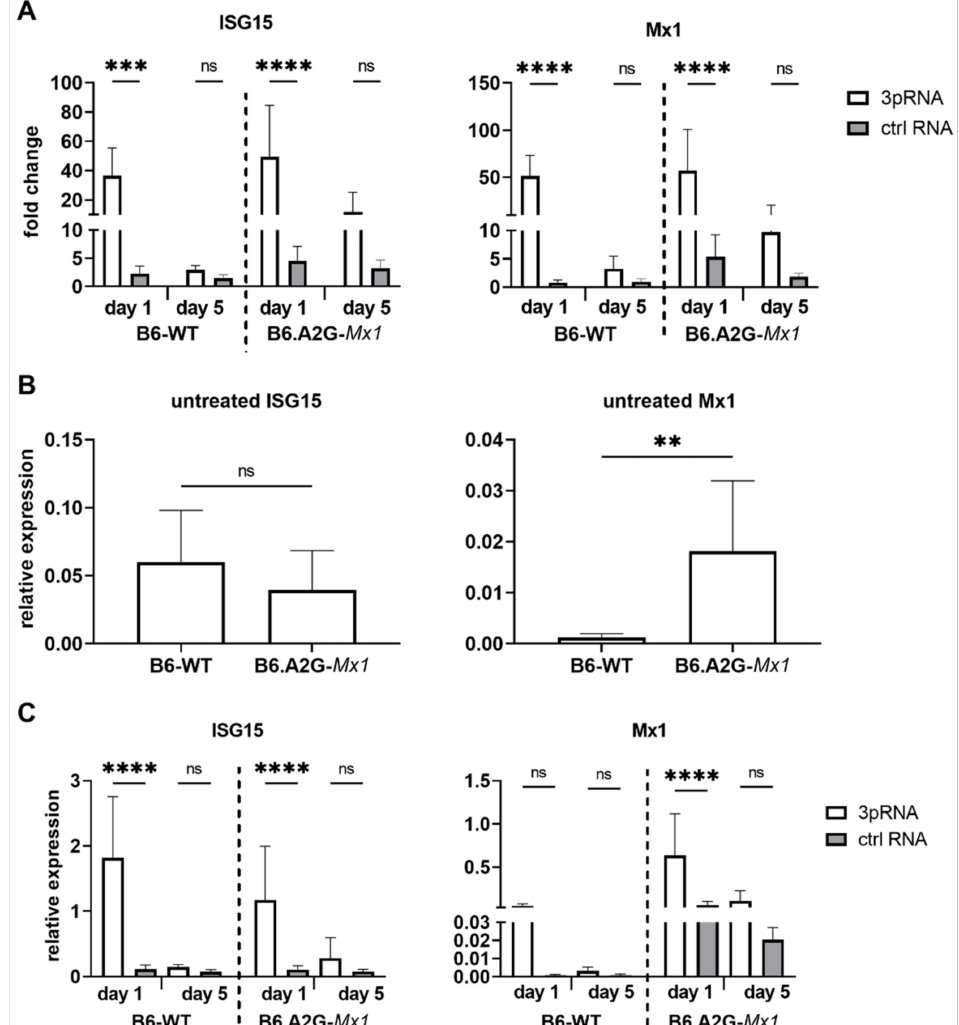
Figure 4. RIG-I agonist-mediated ISG induction in B6.A2G- Mx1 and B6-WT mice. B6-WT and B6.A2G- Mx1 mice received a single i.v. treatment of 12.5 µ g RIG-I agonist (3pRNA) or control RNA (ctrl RNA). After 1 day or 5 days, total RNA was isolated and the expression of ISGs was assessed by qRT-PCR. ( A ) Expression was normalized to GAPDH and is shown as fold induction relative to untreated cells. ( B ) ISG expression relative to GAPDH was determined in untreated cells by calculating 2 − ∆ Ct values. ( C ) ISG expression relative to GAPDH was determined in 3pRNA- (white bars), ctrl RNA- (grey bars) 1 or 5 days after treatment. Data represent the mean ( ± SD) from triplicate samples and are pooled from 2 experiments. A two-way ANOVA with Bonferroni’s multiple comparison test was performed to compare 3pRNA to other conditions in ( A , C ). An unpaired Student’s t -test was performed in ( B ) to compare B6-WT to B6.A2G- Mx1 mice. ** = p < 0.01; *** = p < 0.001; **** = p < 0.0001;